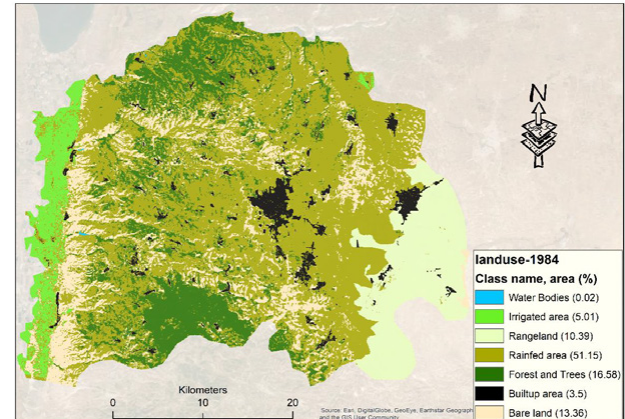
Fig. 3a: Land use in Irbid governorate in 1984